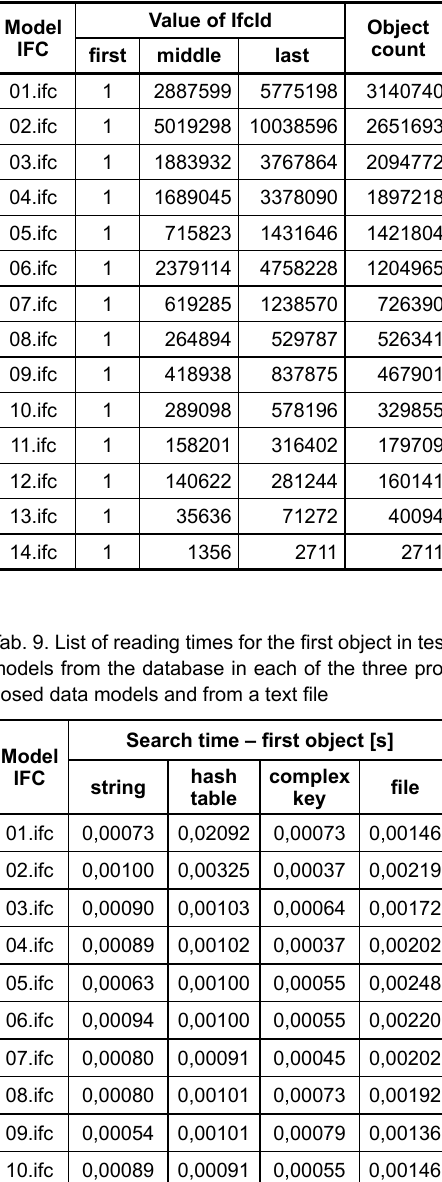
Tab. 8. List of ifcid of first, middle, and last objects in test models